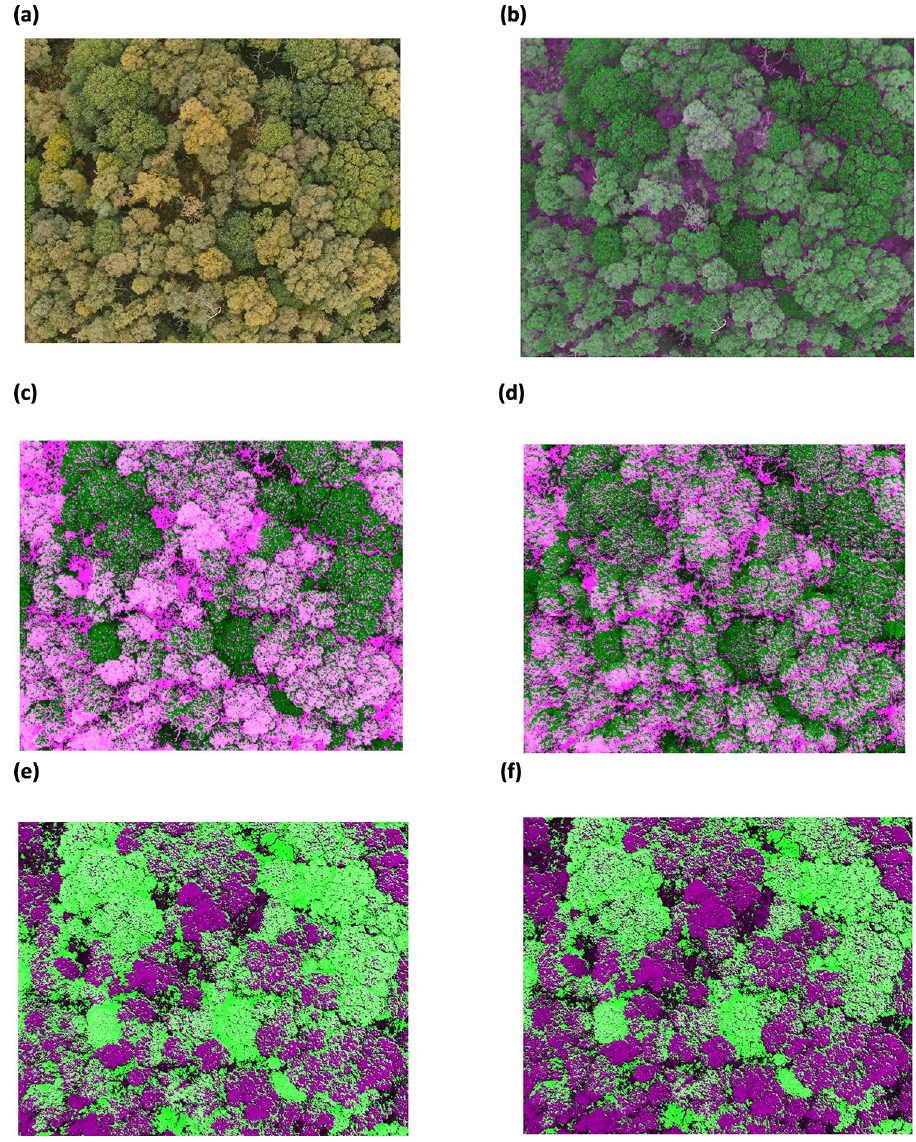
Fig 9. (a) RGB image (b) new NDSI image differentiating oak and silver birch trees (c) Image (14 October 2020) derived from new NDSI thresholding to segment oak and silver birch trees (d) Image (from 17 September 2020) derived from new NDSI thresholding to segment oak and silver birch trees (e) NDVI image after thresholding (f) PCA derived NDVI image after thresholding. segments when compared with the NDVI without weightings from PC1 eigen vectors (Fig 9 (E)). It is noted that the silver birch trees were intensified (in Fig 9(F)) compared to the NDVI image (Fig 9(E)). This clearly demonstrates the significance of the use of PCA classification as the noise from the original multispectral images was reduced, thereby retaining the most important information in each spectral band. While the classification using NDVI with PCA showed possibilities in identifying oak and silver birch trees, its main use has been in its appli- cation to represent the vegetation cover between the reflectance energy in red and NIR spectral bands [41].